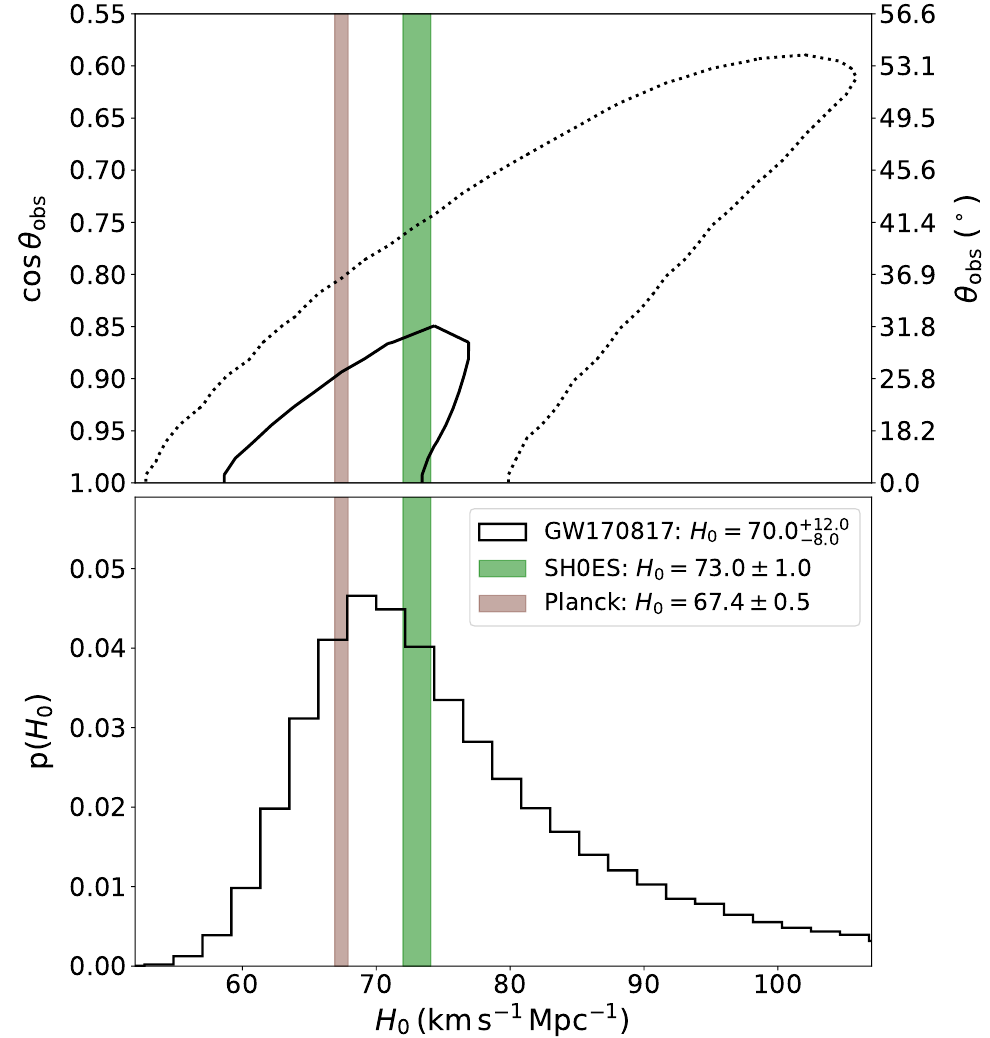
Figure 1. Constraint on H 0 from the BNS merger GW170817 [10]. Figure adapted from [10] and using publicly available data from Gravitational Wave Open Science Center (https://www.gw-openscience. org, aeecssed on 3 May 2022). Copyright 2017 LVK. ( Top ) 2D posterior density of H 0 and the viewing angle θ obs , where 68.3% (1 σ ) and 95.4% (2 σ ) contours are shown with solid and dotted black lines, respectively. The viewing angle θ obs is calculated relative to a face-on observer, i.e., θ obs = 180 ◦ − i , where i is the system inclination obtained from the GW data. ( Bottom ) Marginalized 1D posterior density for H 0 . In both panels, H 0 values inferred from Planck [2] and SHOES [3] are shown with their 1 σ intervals in brown and green, respectively. The inferred H 0 values are reported in the